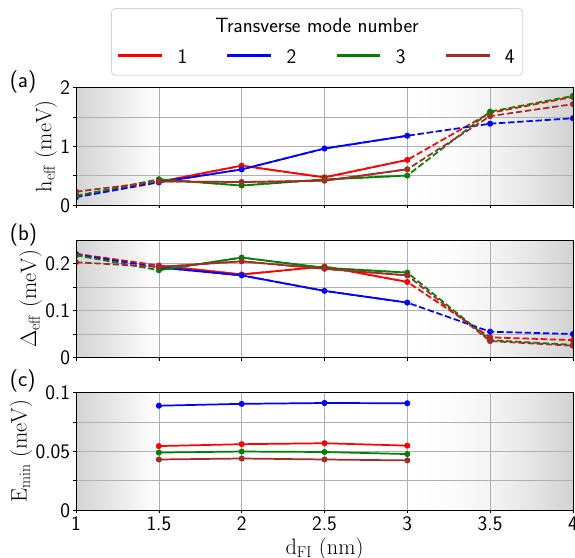
Fig. 5 Effective parameters as a function of FI thickness. a Effective ferromagnetic exchange coupling h eff , ( b ) effective superconducting pairing amplitude Δ eff , and ( c ) topological minigap E min ¼ j E ð k x ¼ k F Þj for the fi rst four occupied transverse subbands (in different colors) versus the EuS thickness d FI . We extract these effective parameters when the subband is close to the Fermi level ( E = 0), and therefore different points necessarily correspond to different V tg values. Shaded regions and dashed lines represent that the system is characterized by a topologically trivial phase (and therefore there is no minigap). The suitable FI thickness d FI for topological superconductivity in the 2D stacking device proposed in this work ranges from ~1.5 to ~3